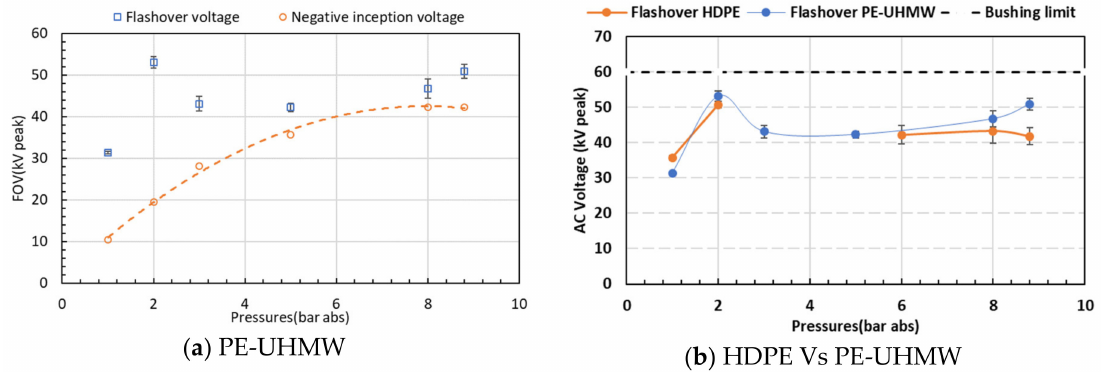
Figure 12. V mean Flashover and negative inception voltages as function of gas pressure (4%Novec TM 4710 / 96%CO 2 , Needle on HV electrode).